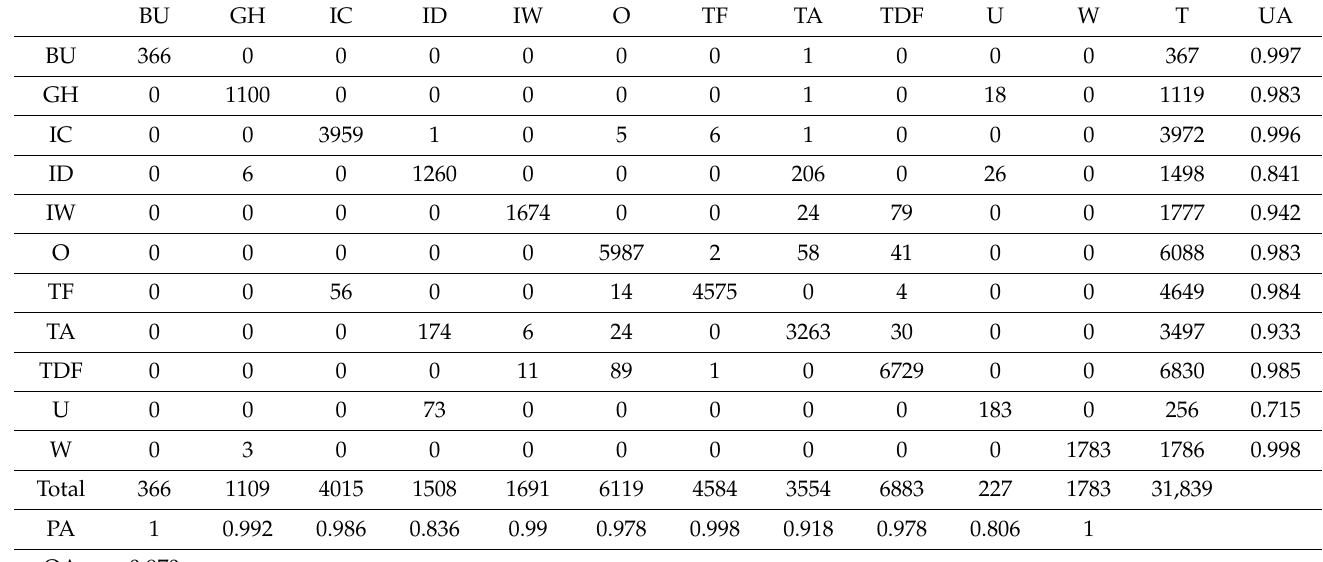
Table A1. Error matrix for accuracy assessment of the classification in 2019 using